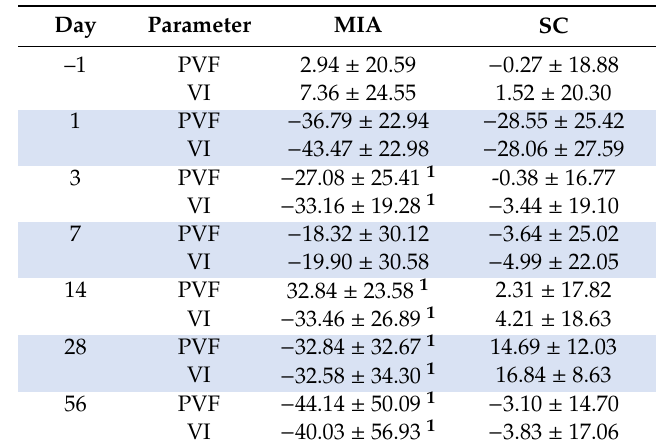
Table 4. Mean values ± SD on each day for asymmetry indices (ASI) of Peak Vertical Force (PVF) and Vertical Impulse (VI) in the MIA (n = 8) and SC (n = 10) groups.